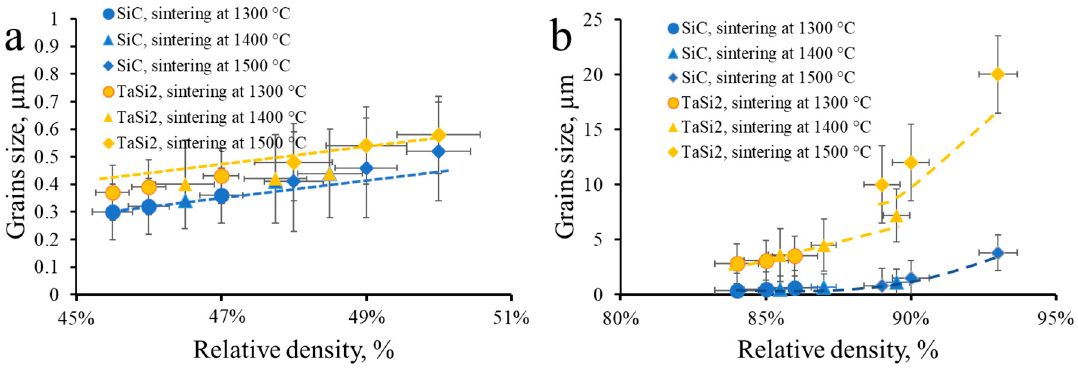
Figure 6. Grain size versus relative density curves. ( a ) For TaSiC composition; ( b ) For TaSiC-nw composition.